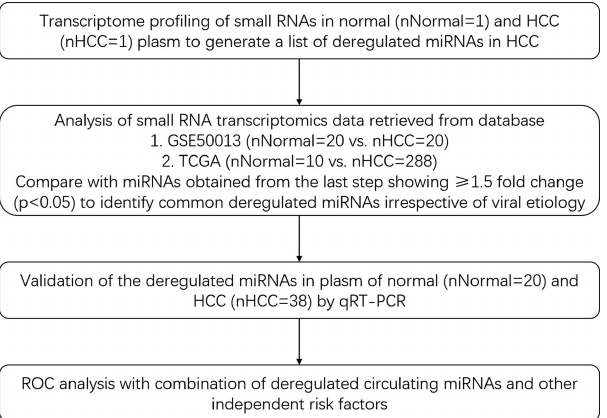
and Figure 1. The schematic presentation of the study